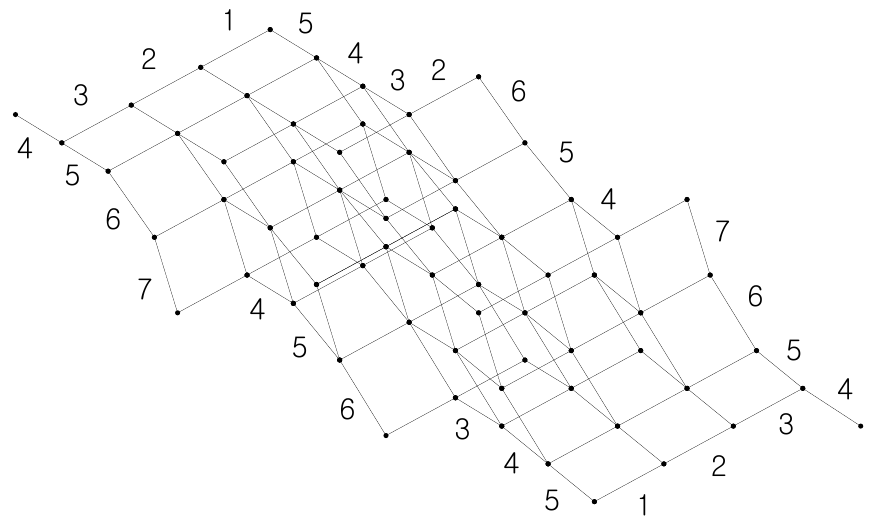
Figure 4 . Vacua and elementary walls in G 8 ; 4 . The numbers indicate the subscript i ’s of simple roots (cid:11) i